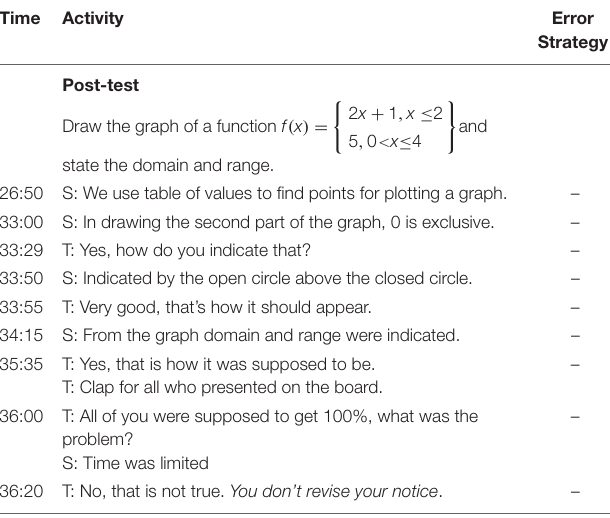
TABLE 7 | Examples of error handling strategies by Teacher 7 in the control condition at the post-test. Time Activity Error